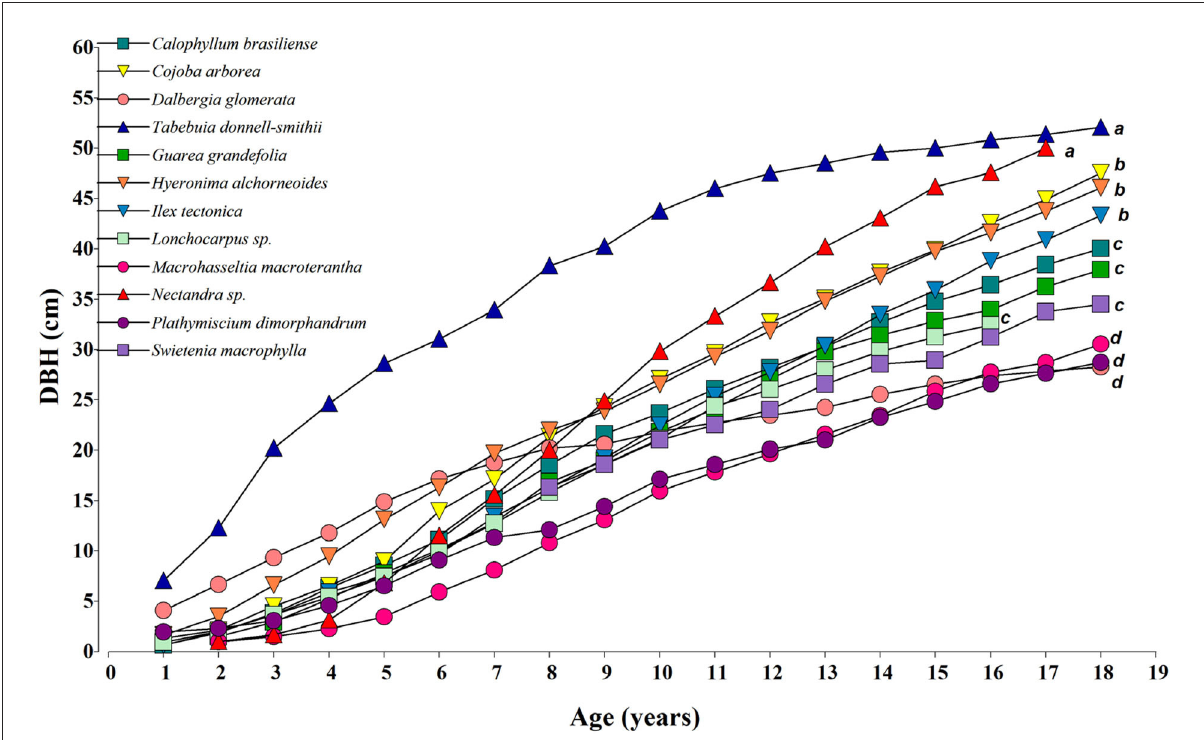
FIGURE3 Diameter growth rate curves (cm) of 12 timber shade species in the experimental site “CEDEC-JAS”, La Masica, Atlántida, Honduras. Means with different letters are statistically different (DGC test, p < 0.05).